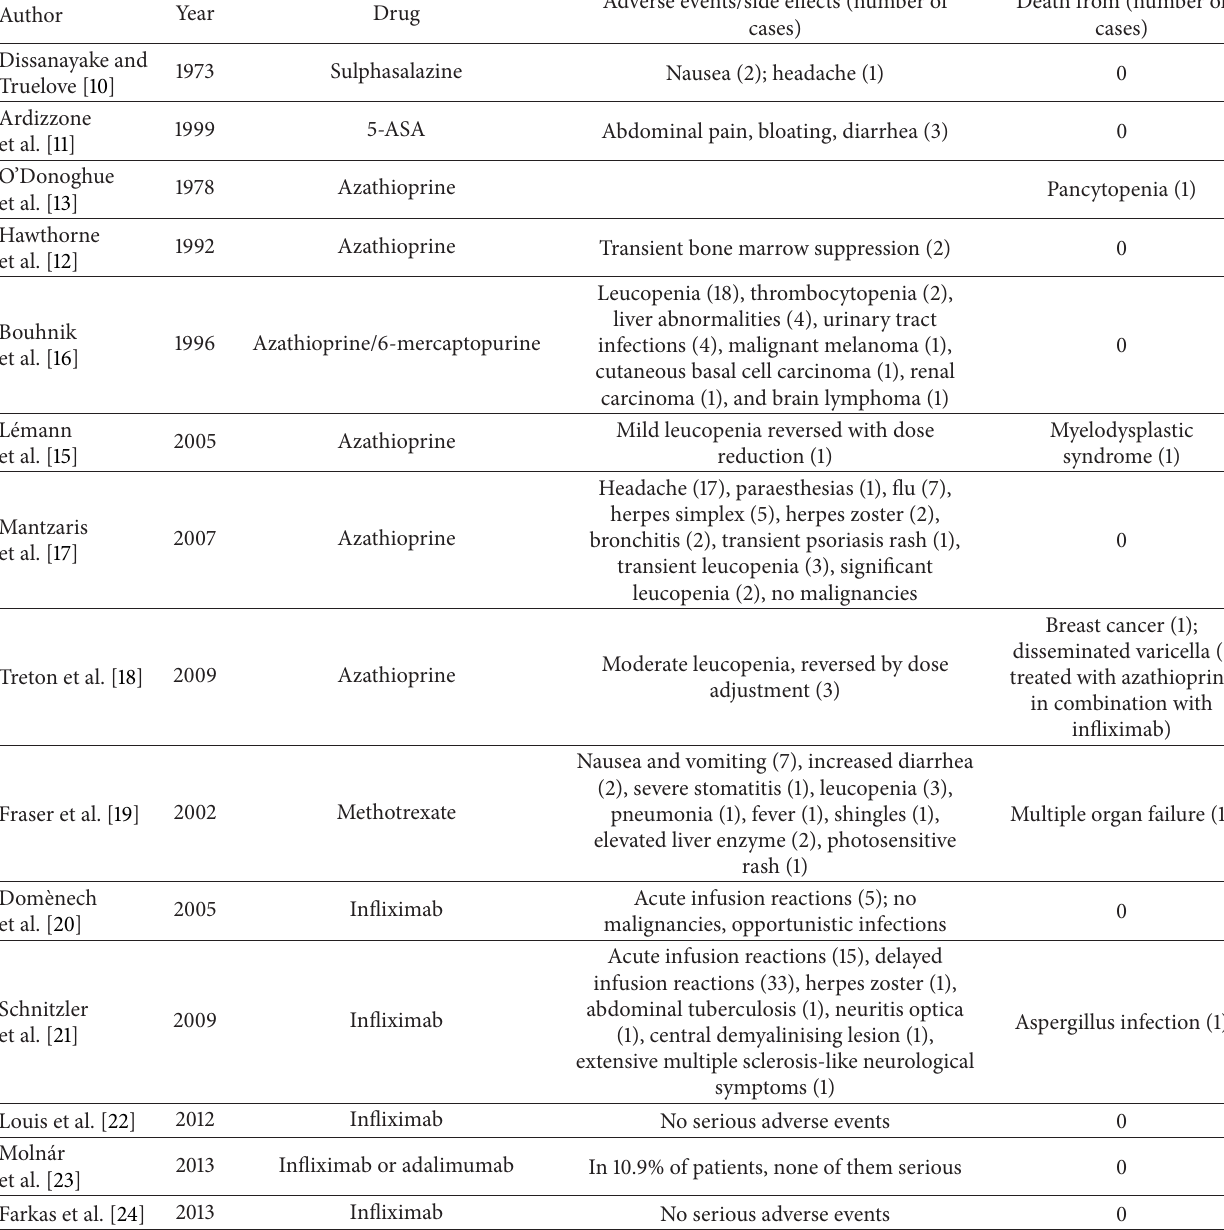
Table 2: Adverse events in pro- and retrospective